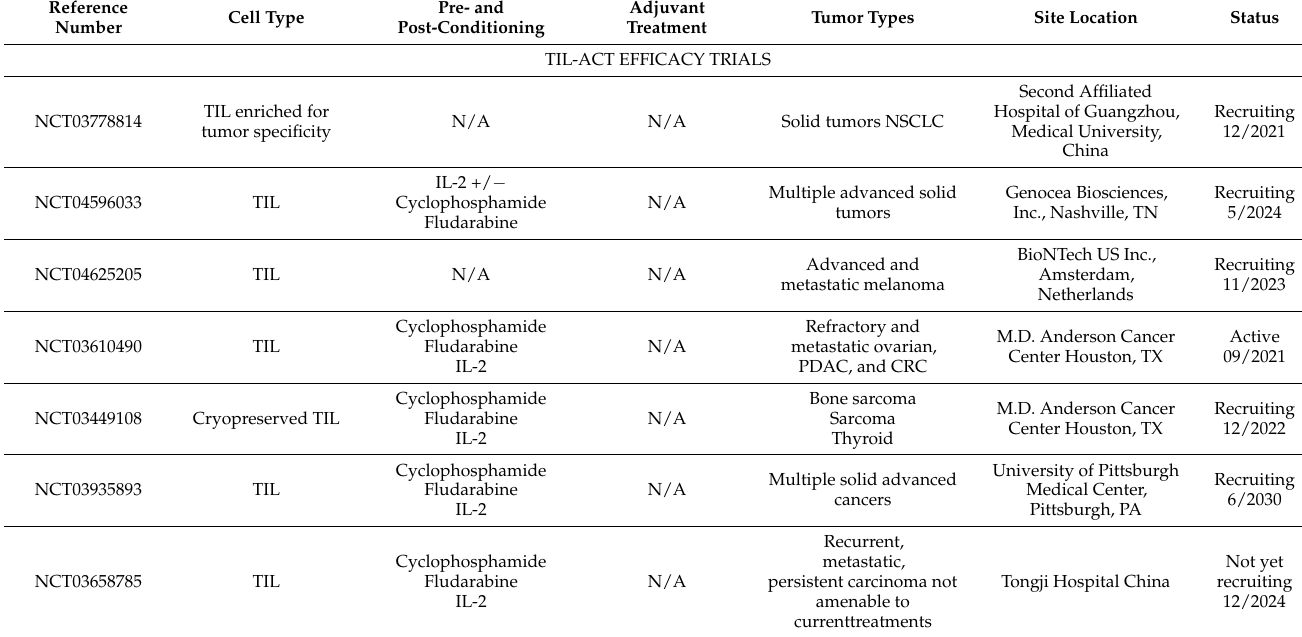
Table 1. List of current and recent clinical trials involving TIL-ACT. Clinical trials are separated into sections dependent on the primary study goal. Derivation from the standard protocol (TIL with cyclophosphamide + fludarabine preconditioning and high dose IL-2 post-conditioning) or experimental therapies are